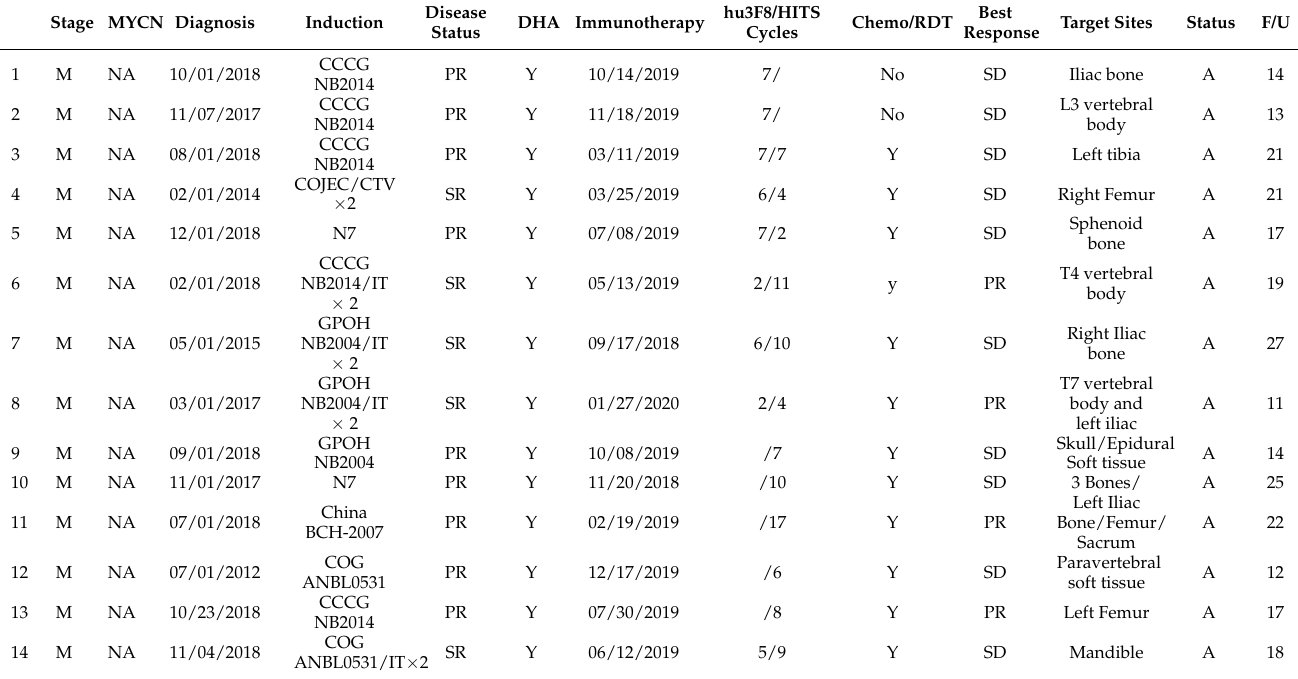
Table 1. Clinical summary of the 14 patients included in the